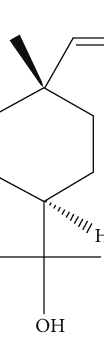
Figure 1: Structure of